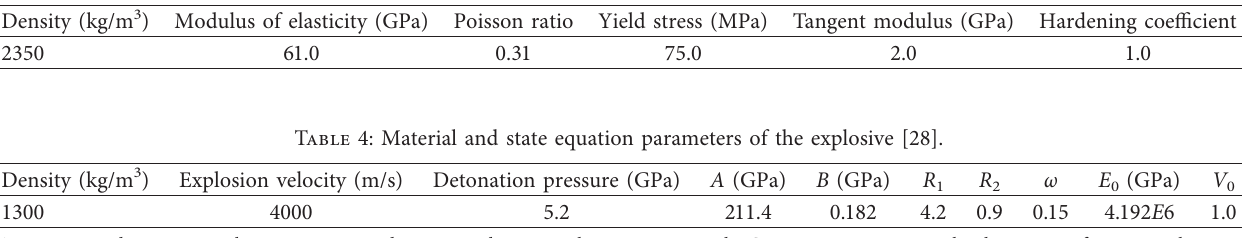
Figure 5: Numerical model and drilling hole pattern. Table 3: Material and state equation parameters of the rock (sandstone) [28].